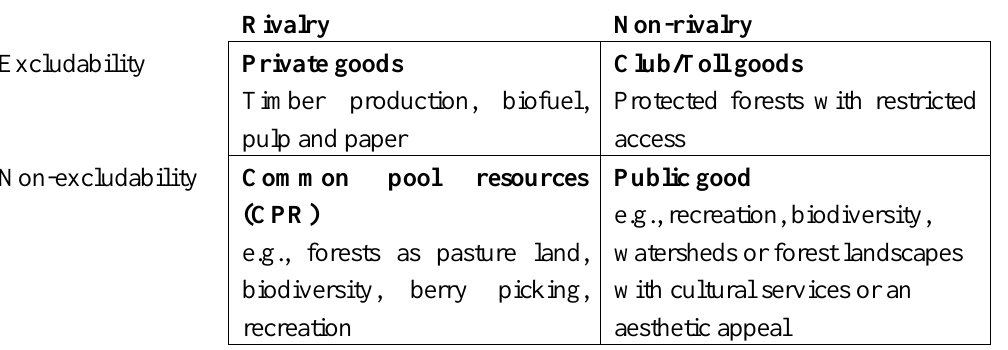
Table 1. Goods dimensions of forested landscapes. Adapted from